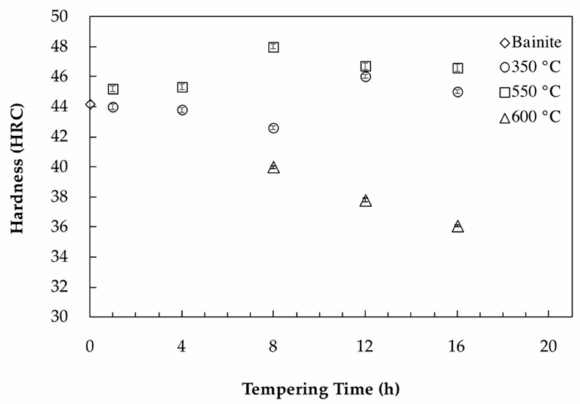
Figure 7. Bainite hardness as a function of tempering time for tempering temperatures of 350 ◦ C, 550 ◦ C and 600 ◦